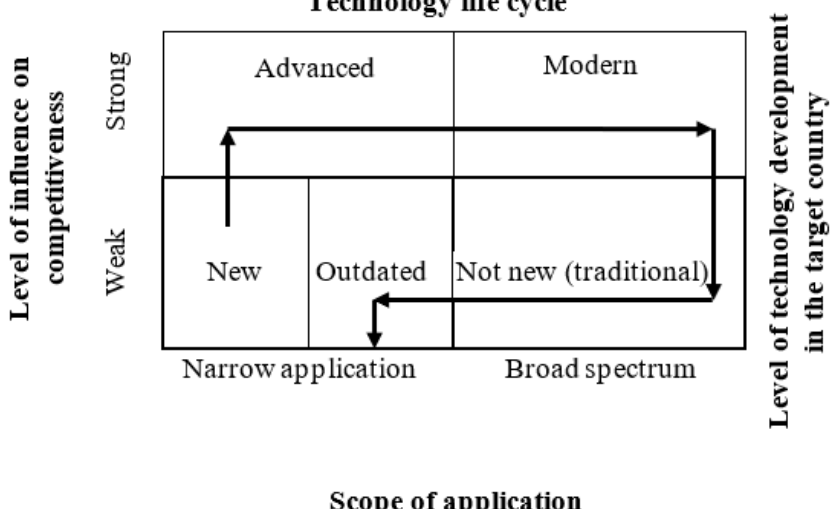
Fig. 1. Analysis of technology in the international marketing